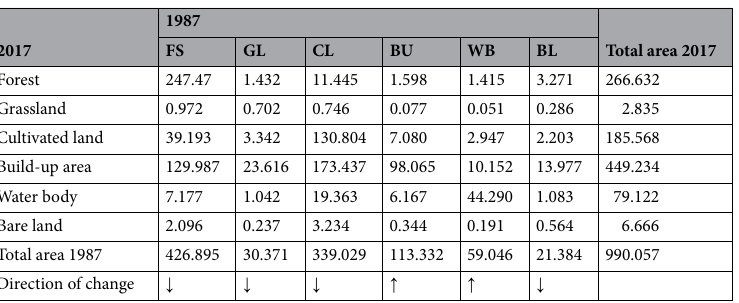
Table 4. Conversion matrix of LULC change (km 2 ) between 1987 and 2017. FS, GL, CL, WB, BU and BL refer to forests, grassland, cultivated land, water bodies, built-up area and bare land,